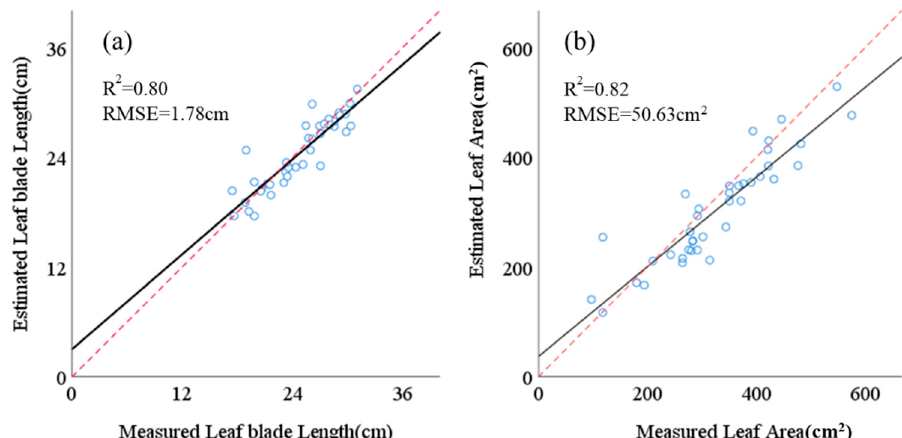
Figure 11. Comparison of the estimated individual leaf area ( a ) and the estimated individual leaf length ( b ) with the measured value. The black and red dashed lines denote the fitting line and the 1:1 line, respectively.